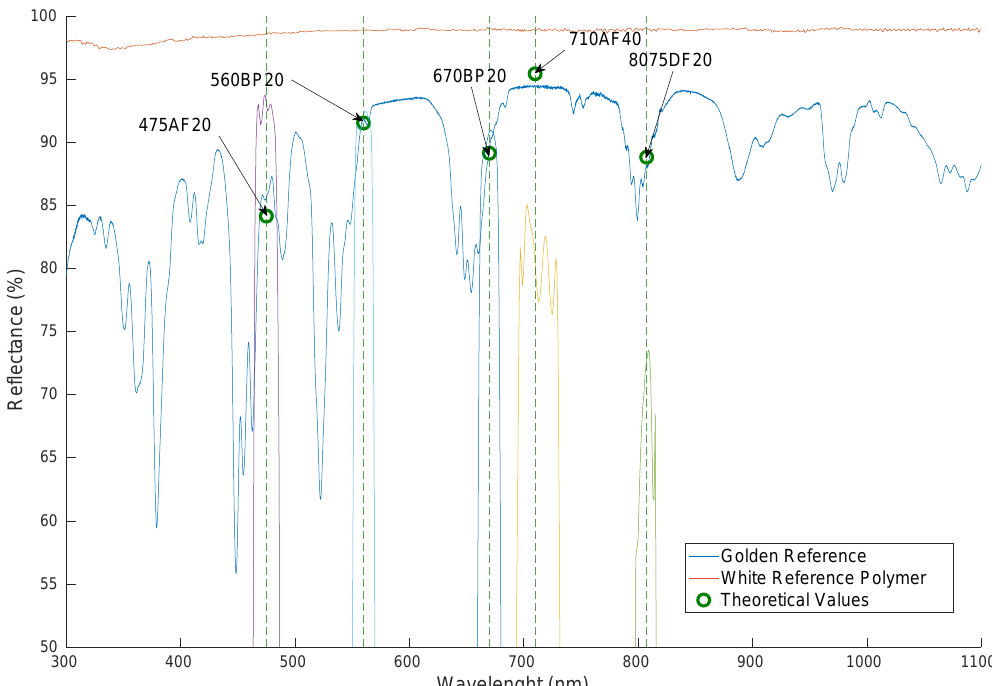
Figure 9. White and golden references with the theoretical values calculated for each individual band pass